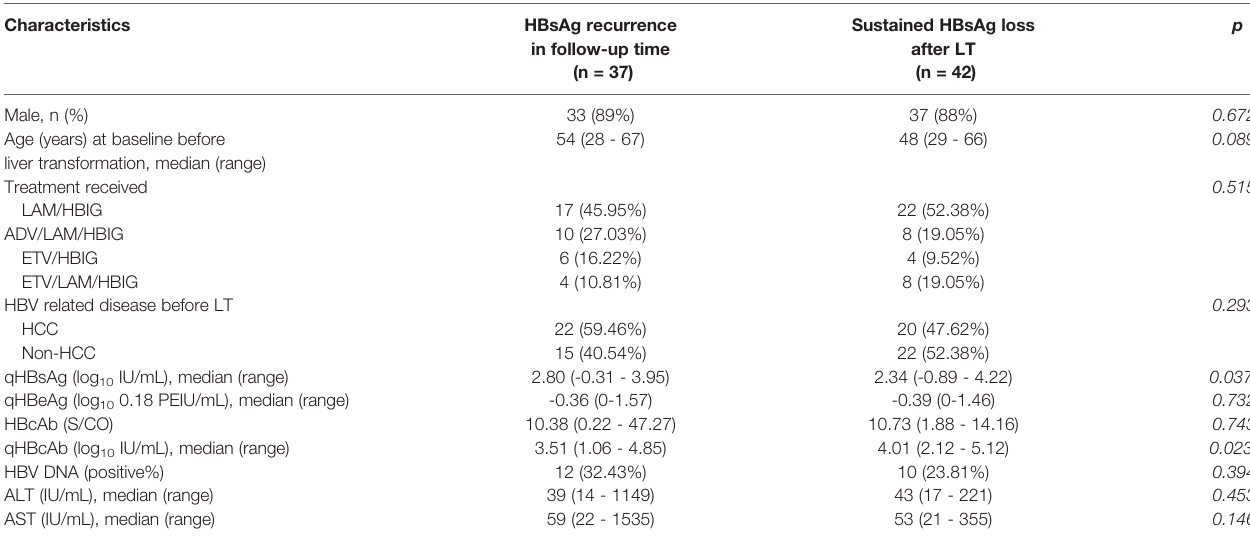
TABLE 1 | Characteristics of enrolled patients at